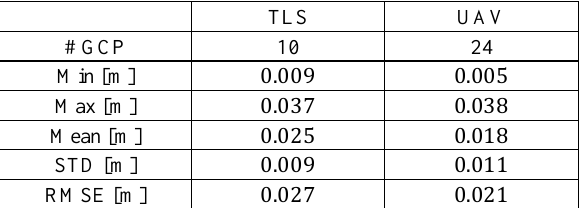
Table 2. S tatistical figures for both point clouds accuracy.